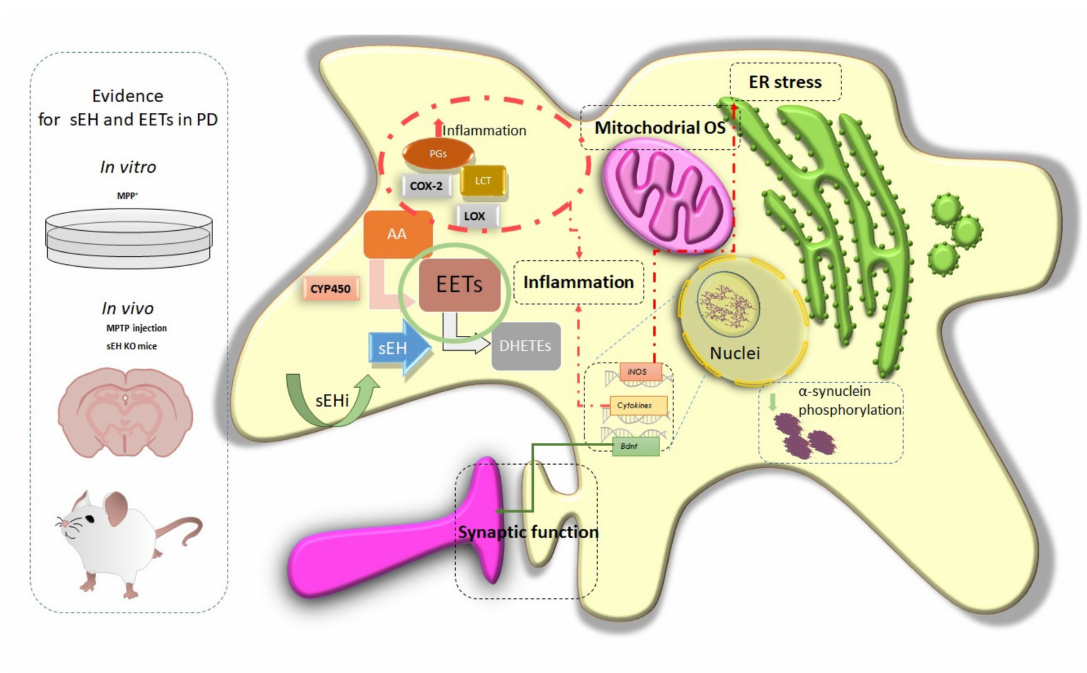
Figure 3. Representative scheme of sEH implication in PD and hot spots of pharmacological activity for sEH modulation. Dotted red line and green line indicated putative regulation role for